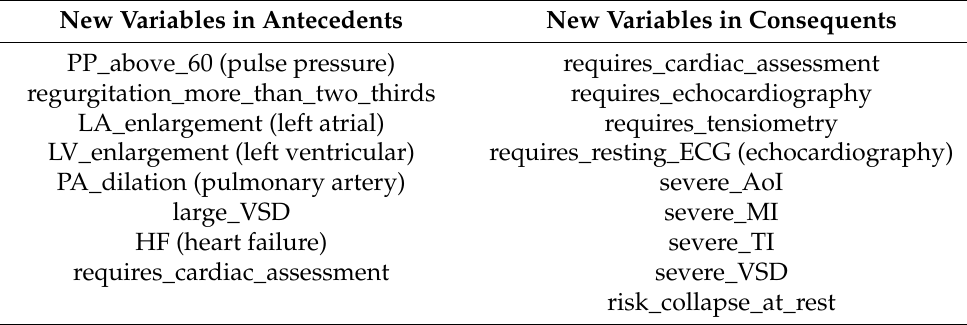
Table 3. Subsystem II (second level input data and conclusions/ask for more data).